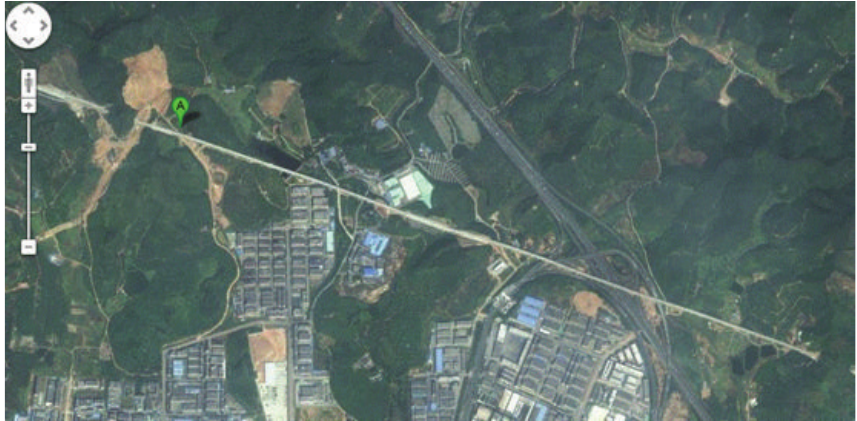
Figure 1: Satellite map of measured hilly terrain area.